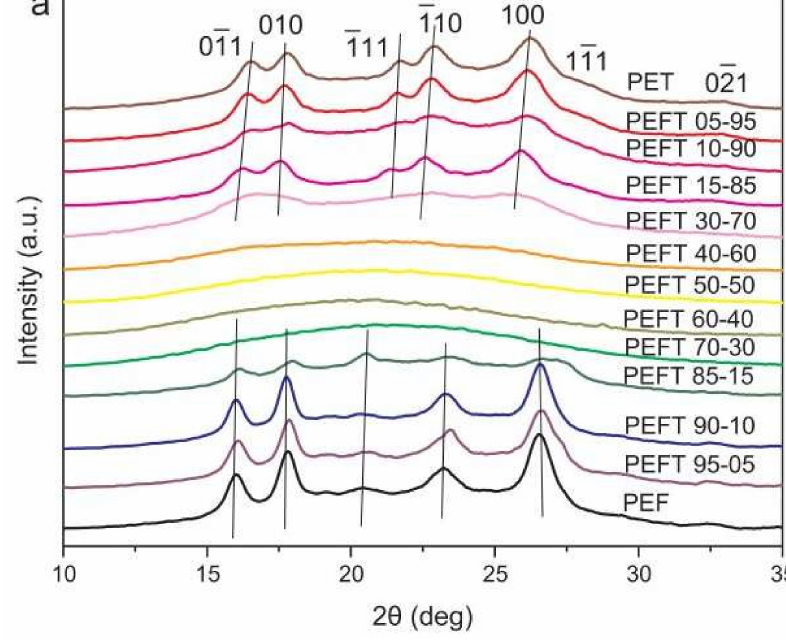
Figure 9. XRD di ff raction patterns of random PEFT copolymers